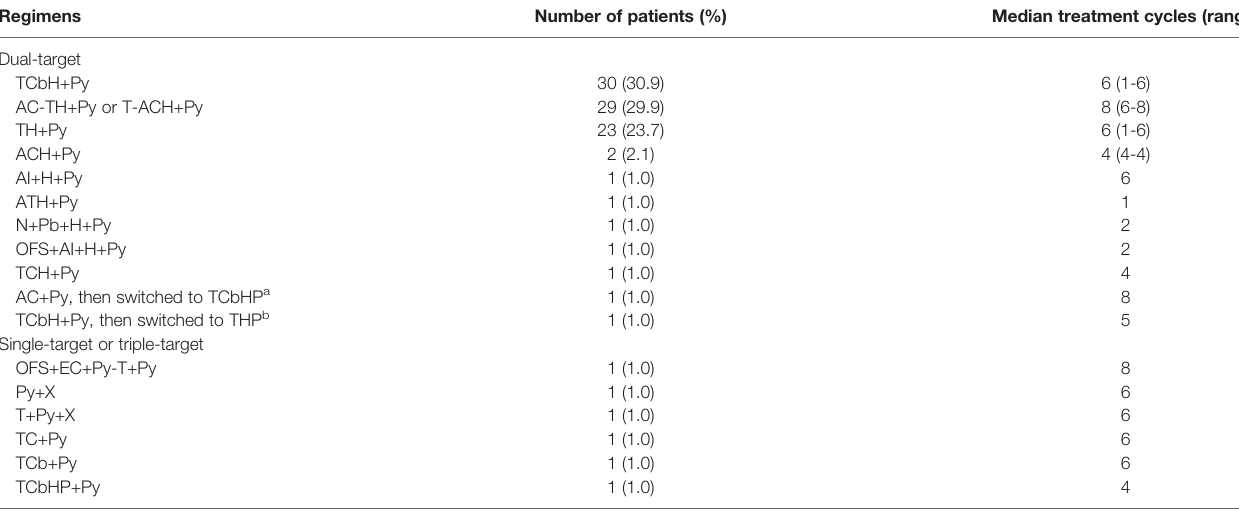
TABLE 2 | Neoadjuvant therapy regimens (N = 97).